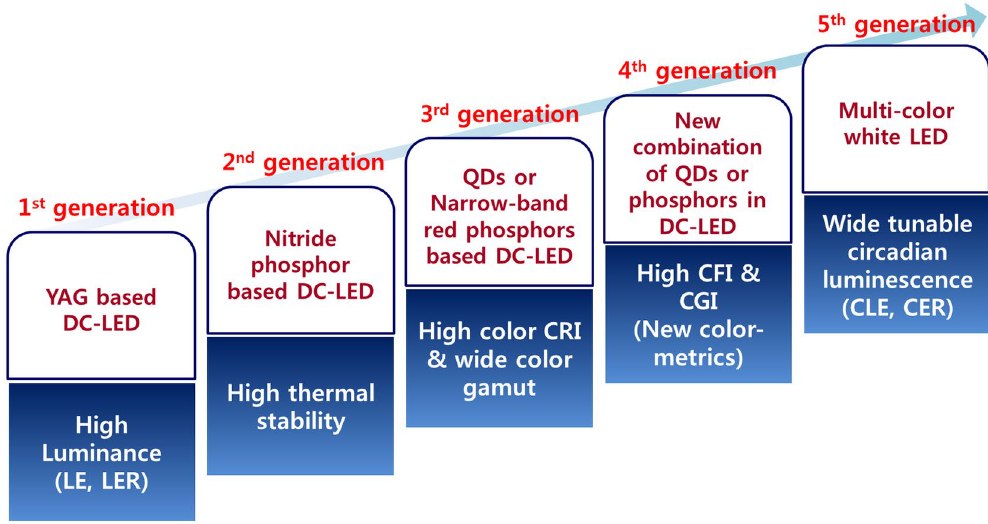
Figure 1. Schematic diagram of the development approaches for the first through fifth generations for general WLED lighting devices. [Luminous efficacy (LE), luminous efficacy of radiation (LER), color rendering index (CRI), color fidelity index (CFI), color gamut index (CGI), circadian luminous efficacy (CLE), and circadian luminous efficacy of radiation